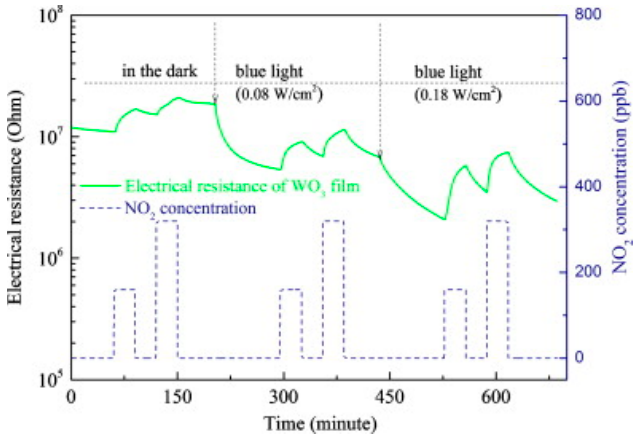
Figure 19. NO 2 sensing curve vs. blue light intensity. Reproduced with permission from [56].